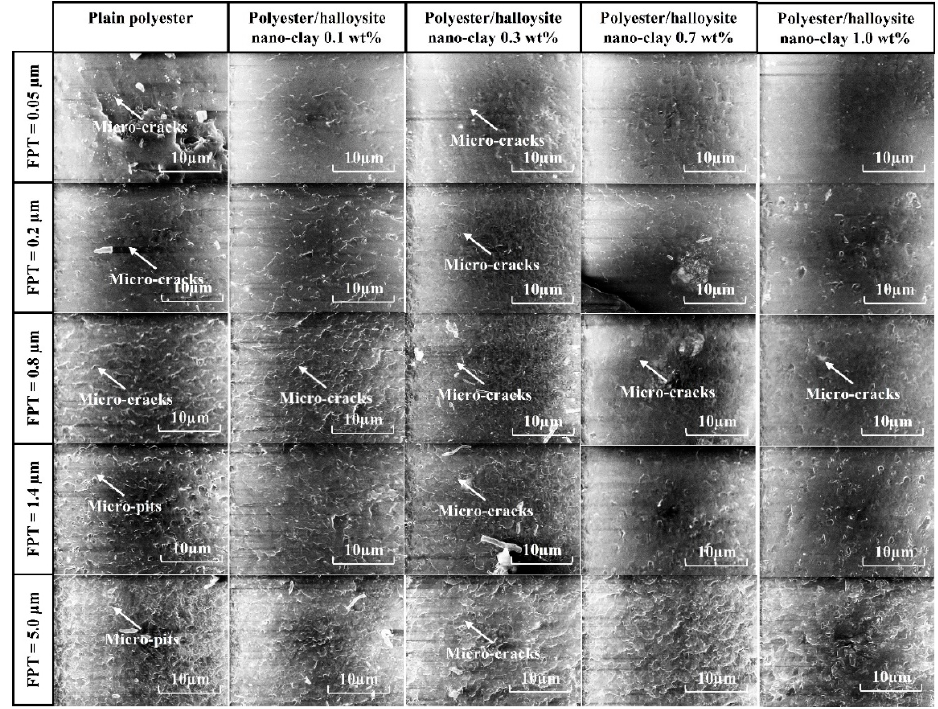
Figure 13. SEM graphs of slot bottoms of various polyester/halloysite nano clay at zoom 6000×.